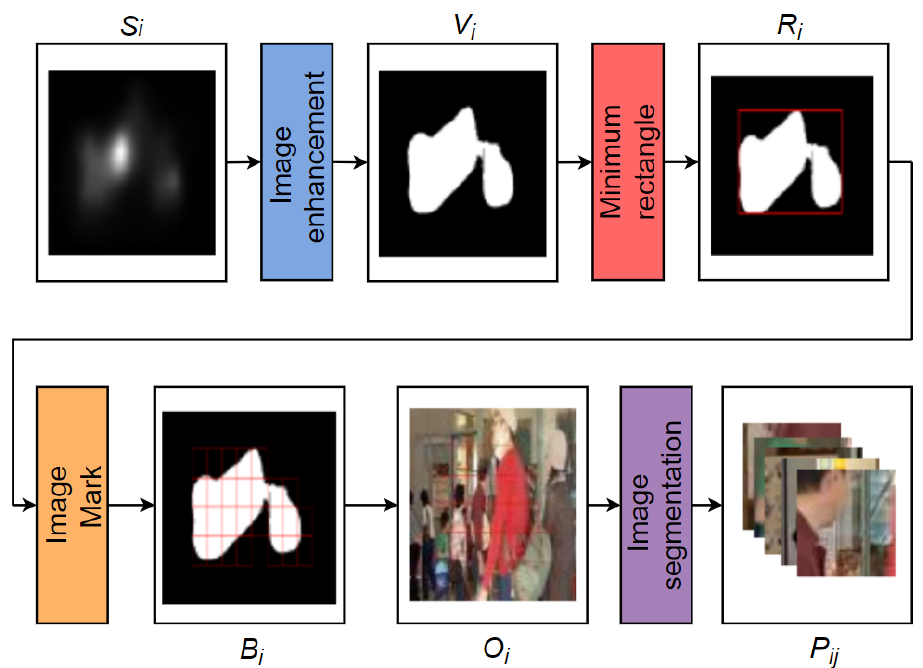
Figure 7. The process of image patch